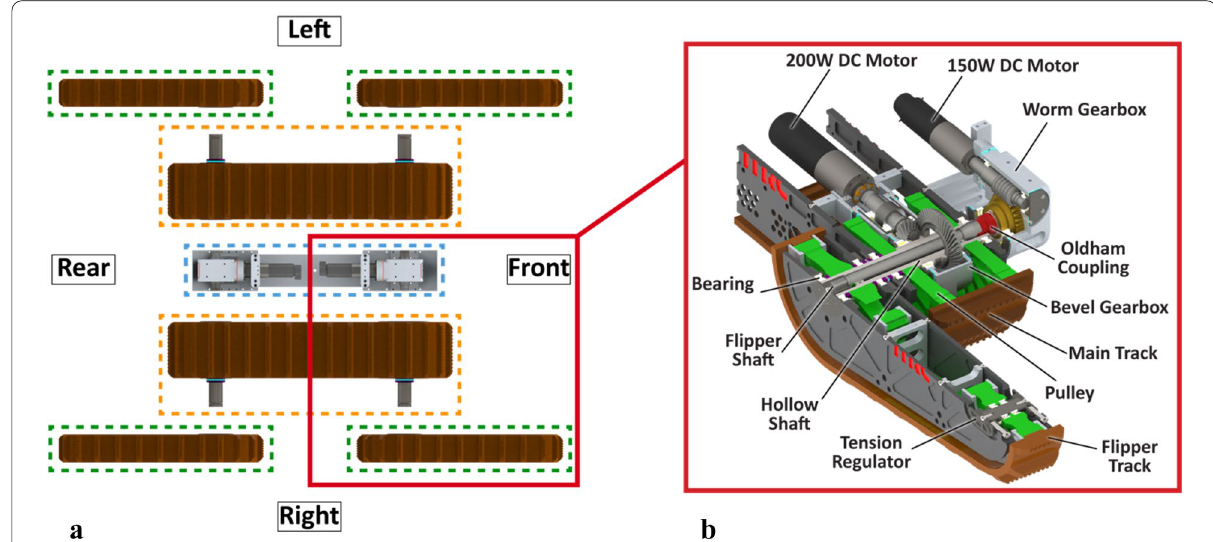
Fig. 7 Module arrangement and detail design of Karo’s locomotion mechanism in